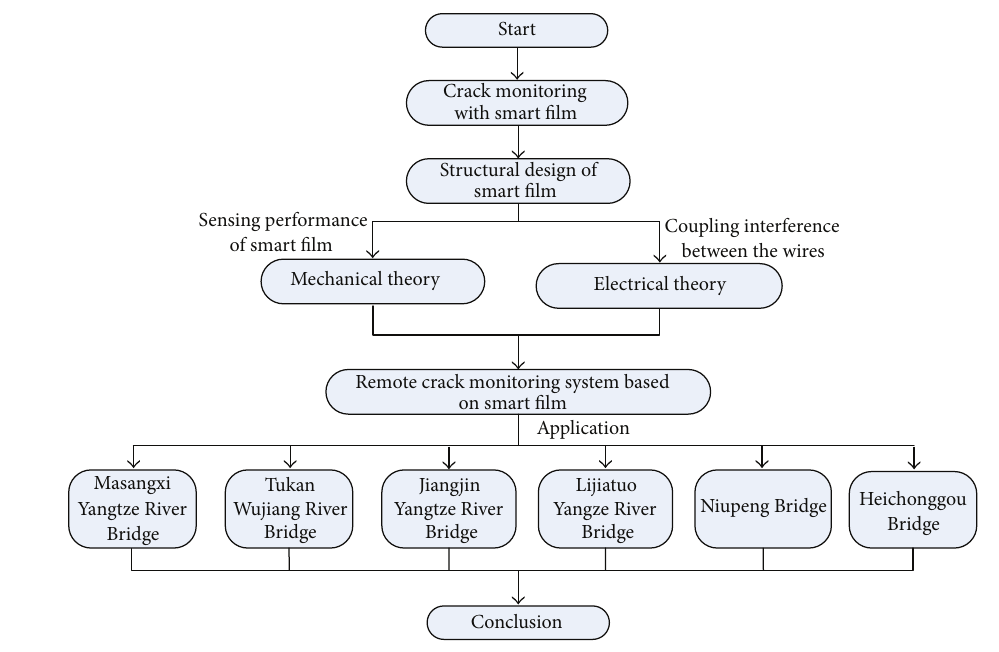
Figure 2: Diagram of the logic structure of this paper.